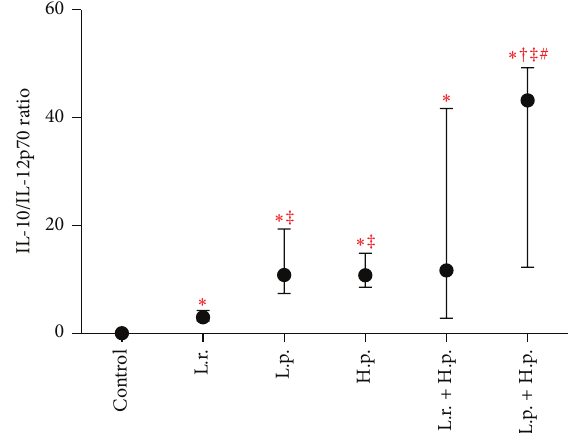
Figure 3: The cytokine IL-10/IL-12p70 ratio. Values expressed as medians from the ratios from six independent experiments and interquartile ranges [Q1–Q3]; control: unstipulated DCs; L.r.: L. rhamnosus 900; L.p.: L. paracasei 915; and H.p.: H. pylori ; statistically significant differences are given as follows: ∗ : stimulators versus control (unstimulated DCs), † : stimulators versus H. pylori, ‡ : stimulators versus L. rhamnosus 900, stimulators versus L. paracasei 915; 𝑃 < 0.05 ; DCs: dendritic